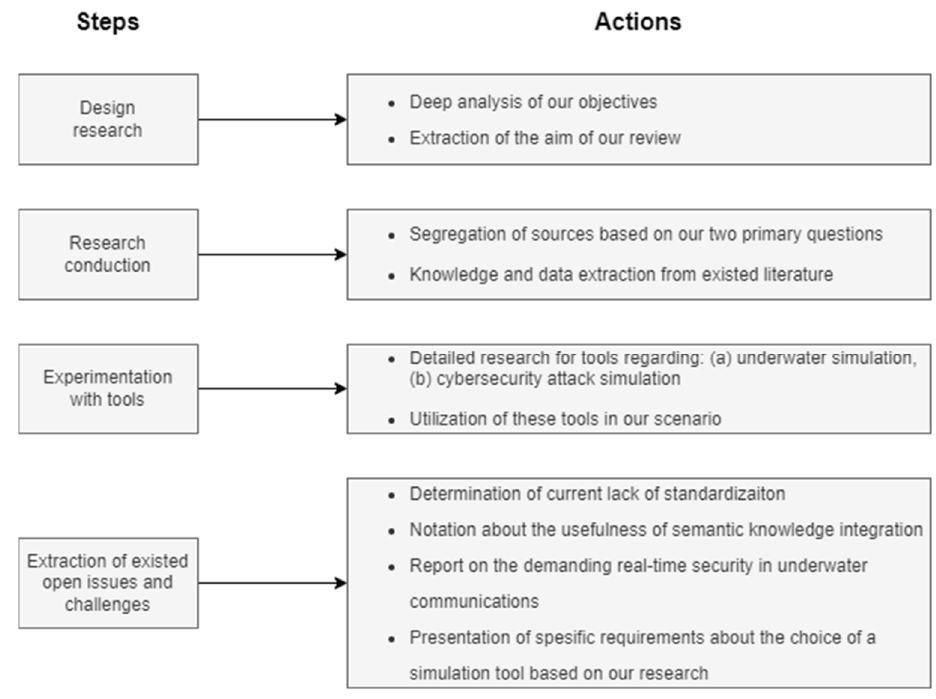
Figure 4. Steps of conducted research.